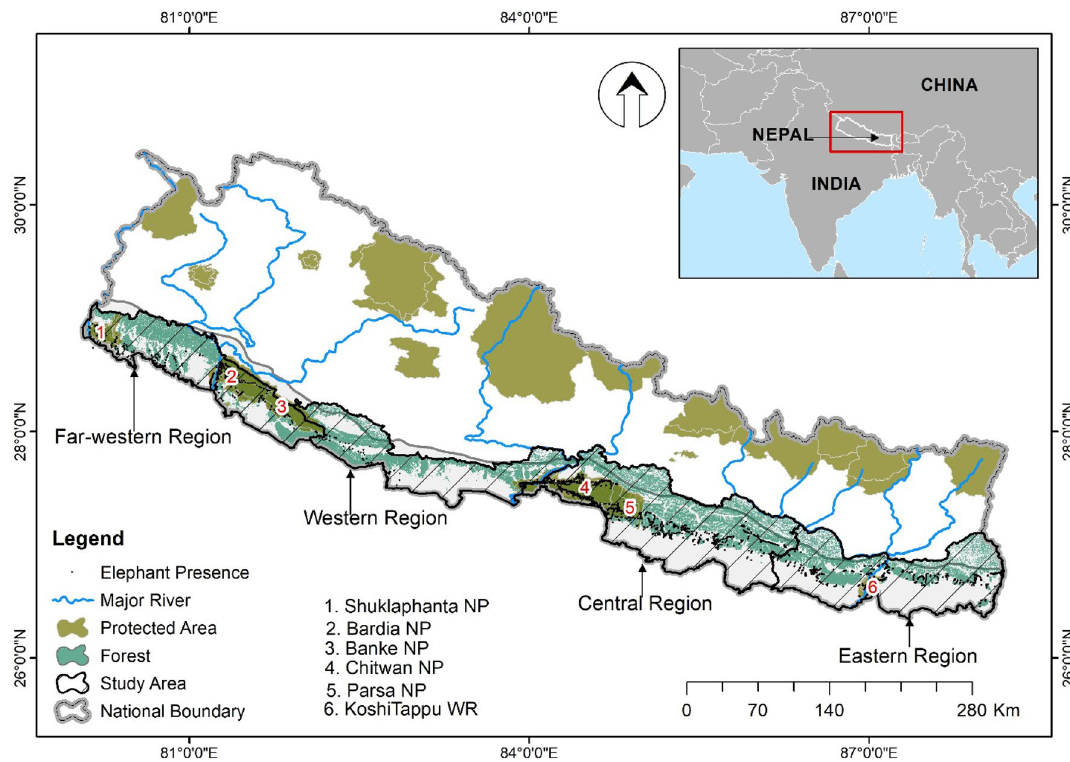
Figure 3. The geographical location of Nepal and the study area (Chure Terai Madhesh Landscape). Map generated by Ashok Kumar Ram using ArcGIS 10.5 101 .